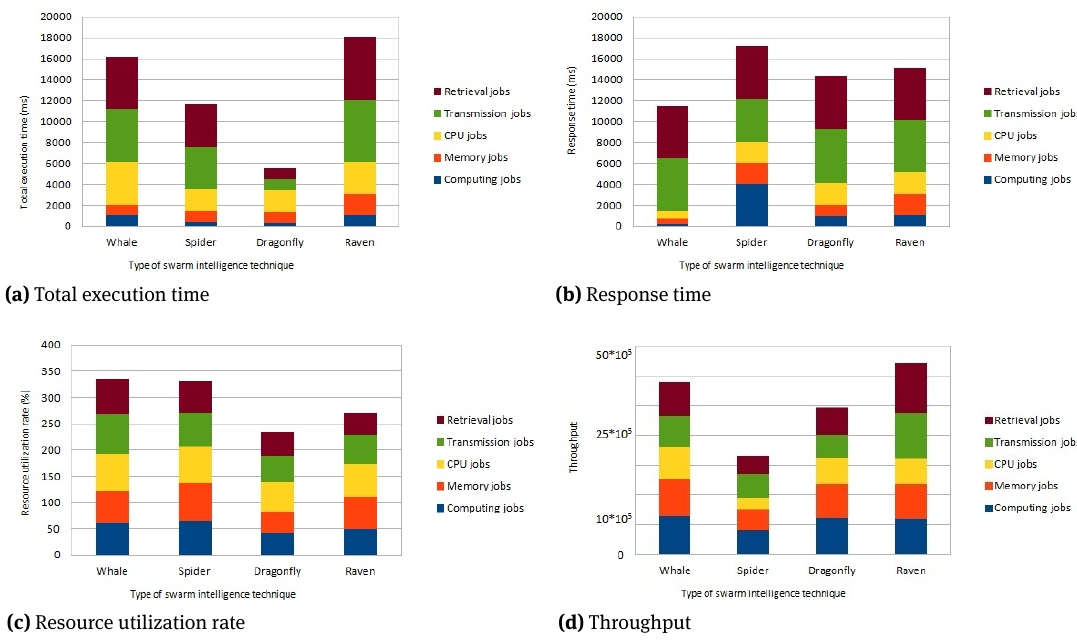
Figure 8: Performance under scenario-3